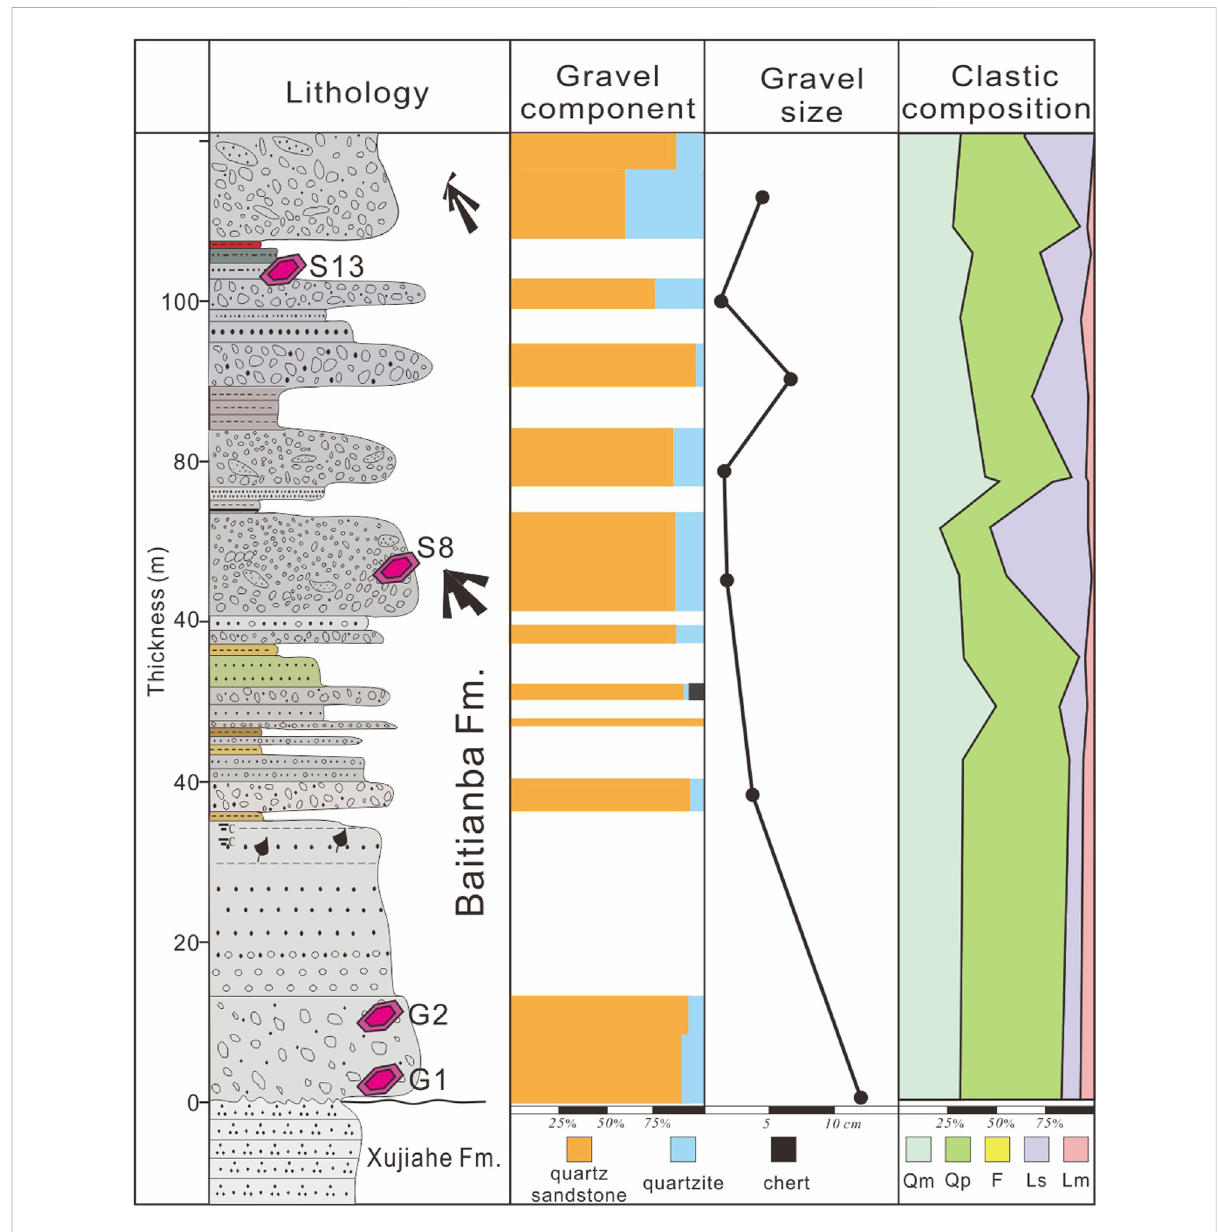
FIGURE 3 Lithostratigraphy, gravel component and sandstone composition of the Jinzishan outcrop. Qm: monocrystalline quartz; Qp: polycrystalline quartz; F: feldspar; Ls: sedimentary rock fragments; Lm: metamorphic rock